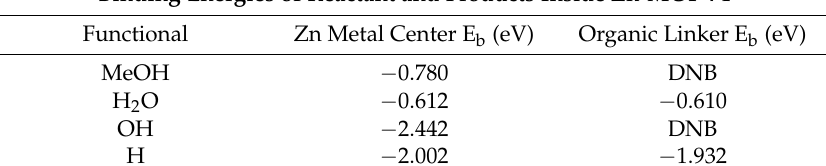
Table 2. Calculated binding energies (in eV) of reactants and products to both the Zn metal center and the organic linker prior to and after water dissociation for a methanol/water mixture. DNB indicates that the functional did not bind.